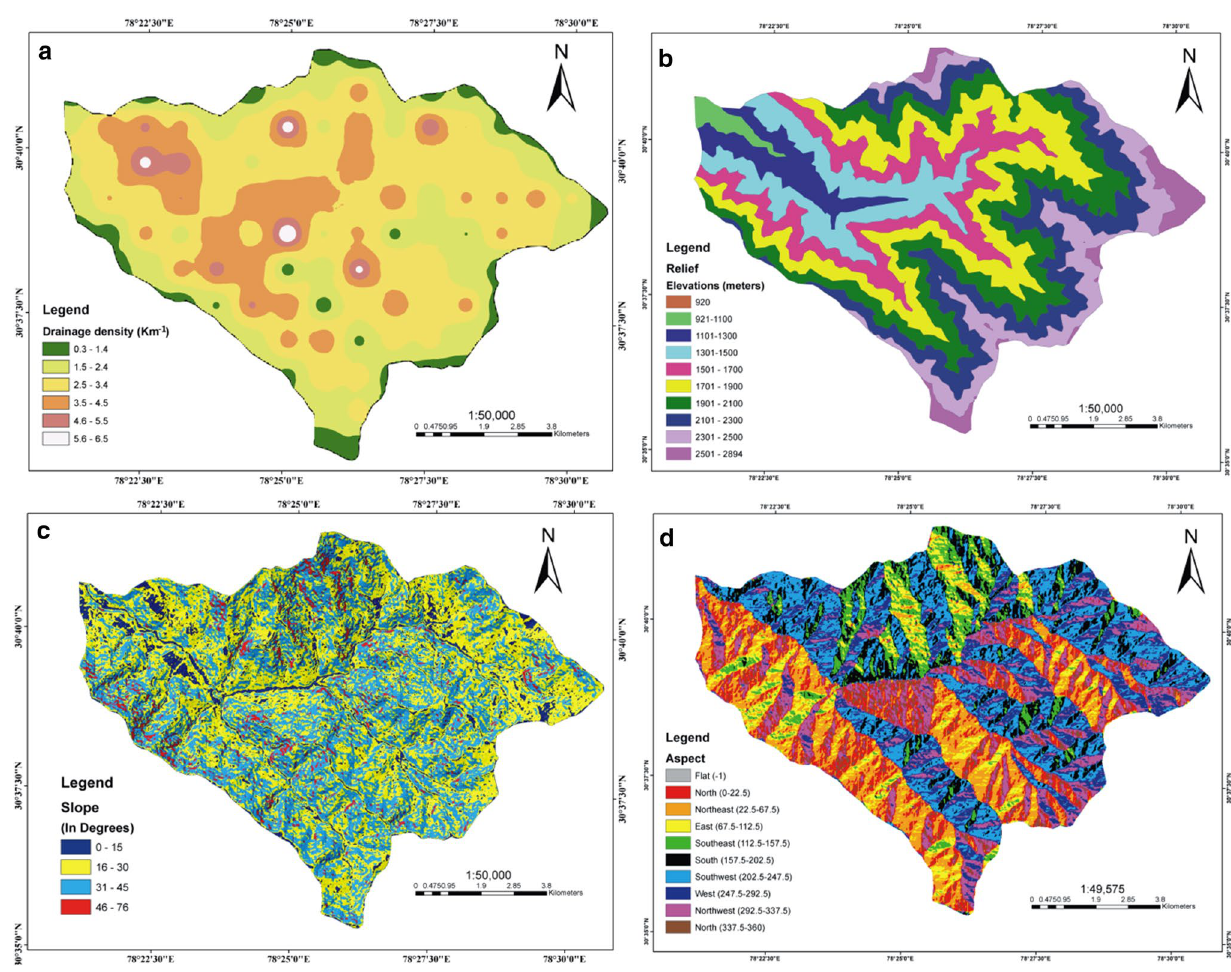
Fig. 4 a Drainage density map b Relief map c Slope map and d Slope aspect